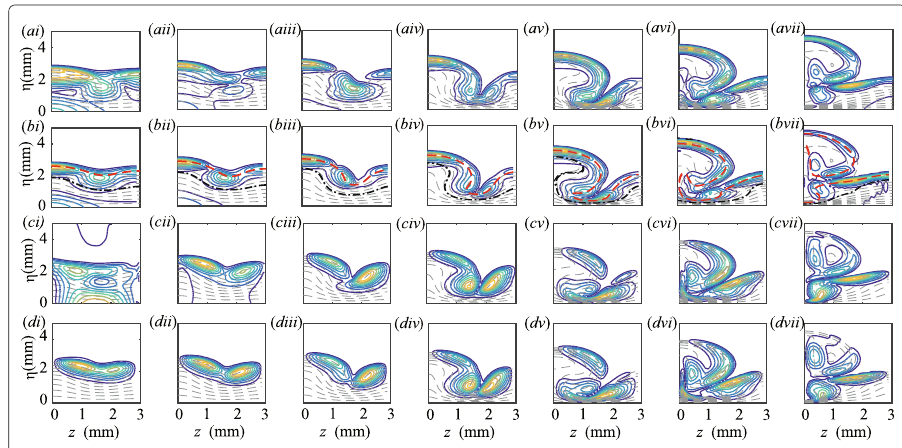
Fig. 9 Isolines of normalized temperature disturbances of the varicose mode of 135 kHz ( a , b ) and the sinuous mode of 95 kHz ( c , d ) at various streamwise locations obtained by DNS ( a , c ) and PSE3D ( b , d ) , together with the base flow (dashed lines). Critical layer (dashed red) and relative sonic line (dash-doted black) are also plotted in the row ( b ). The Roman numbers denote the streamwise locations ( i ) 136 mm, ( ii ) 167 mm, ( iii ) 197 mm, ( iv ) 228 mm, ( v ) 258 mm, ( vi ) 289 mm, ( vii ) 319